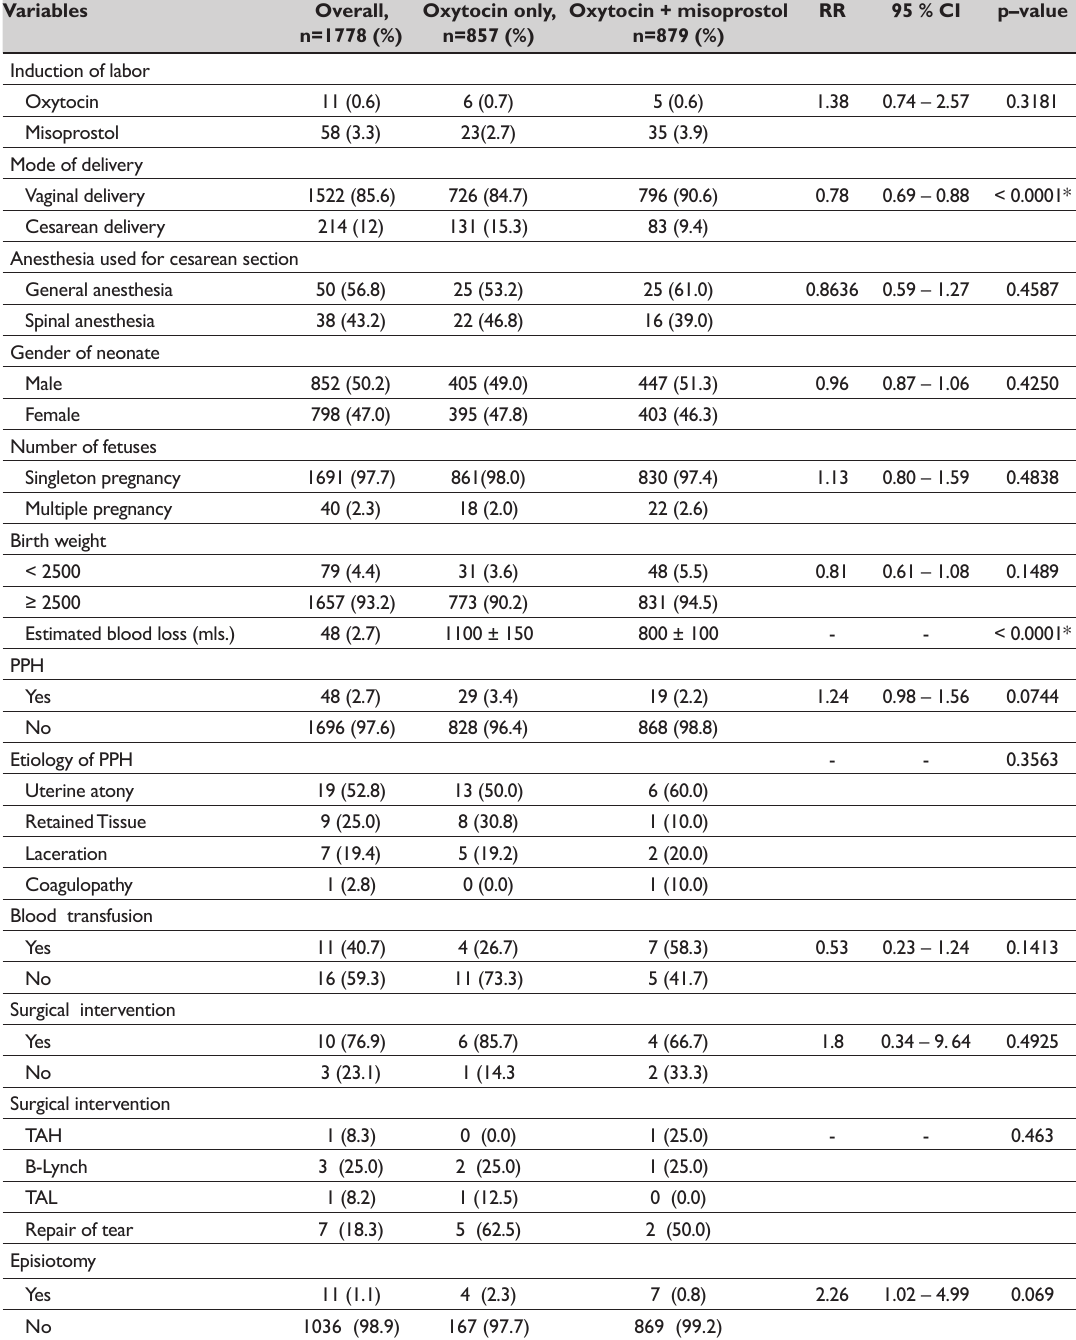
Table 2: Intrapartum characteristics and management of postpartum hemorrhage